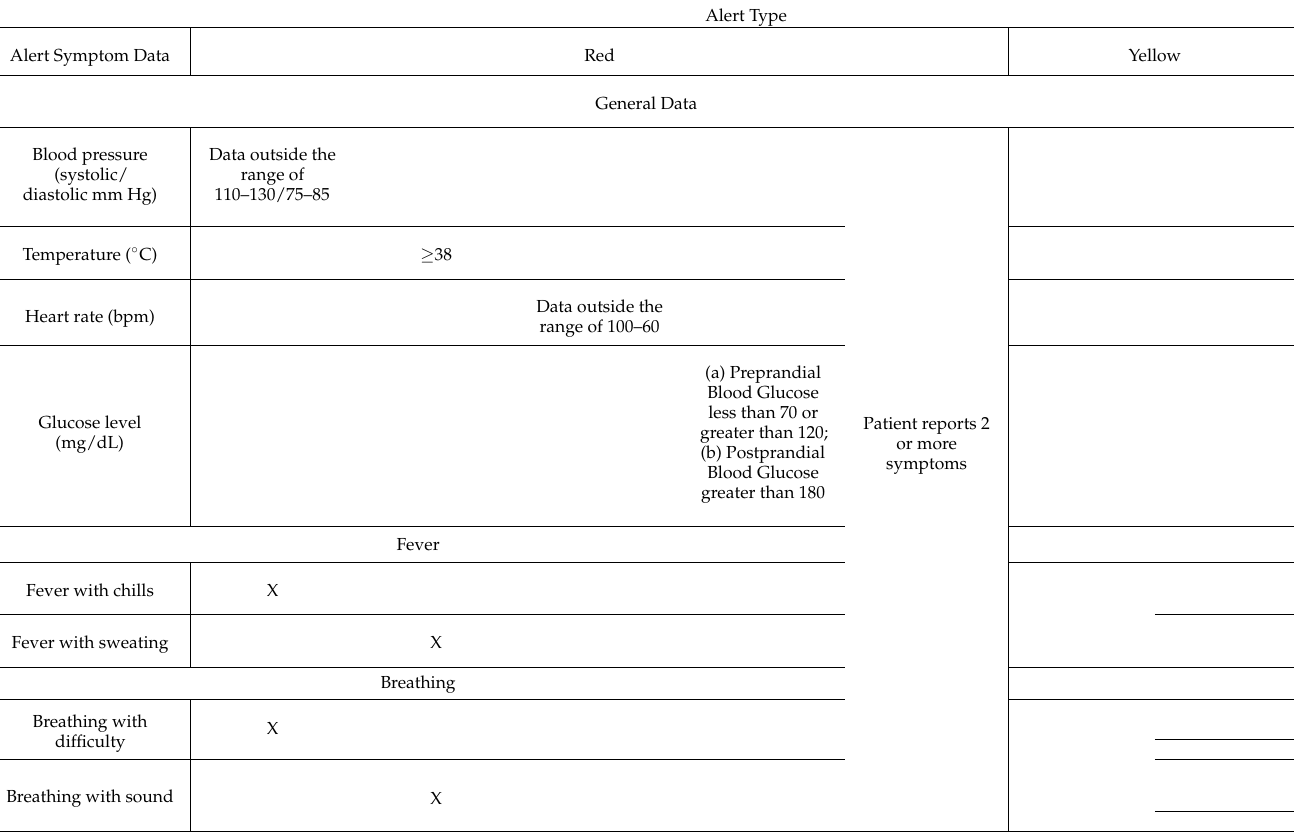
Table A1. Identification and classification of risk situation